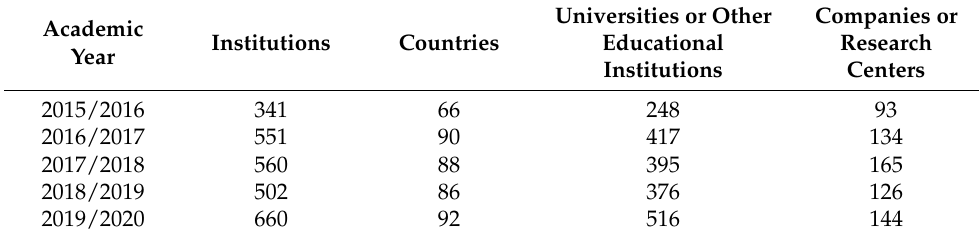
Table 1. GIM download data.